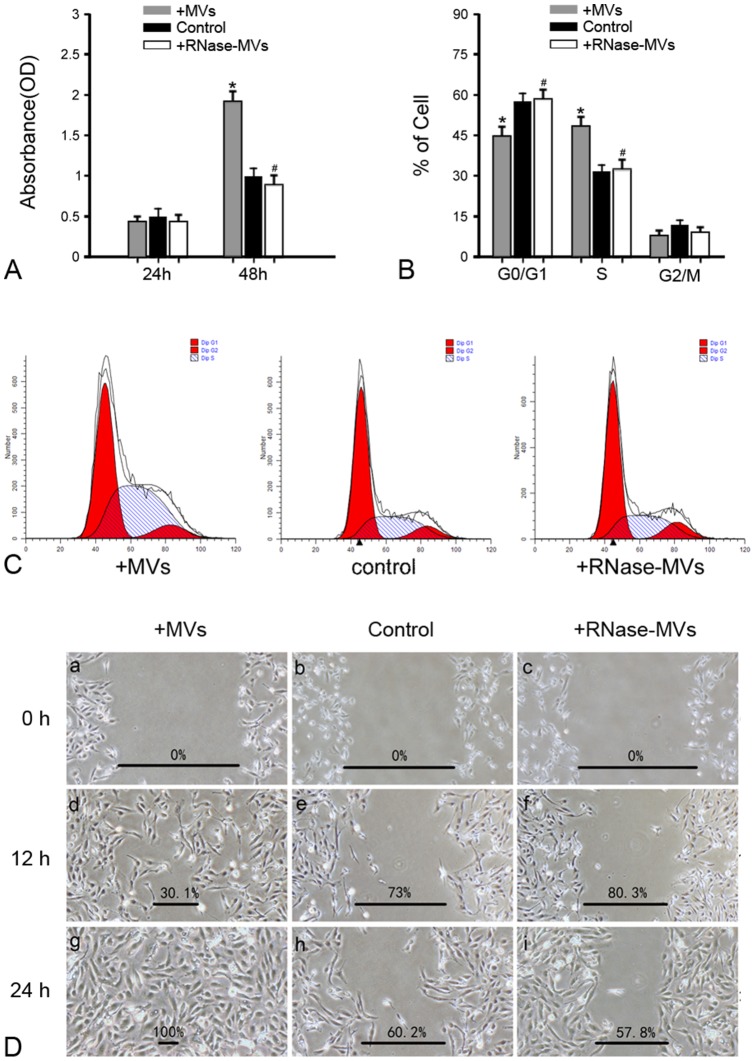
MVs promote the growth and migration of 786-0 cells in vitro.
(A) CCK-8 Assay. After 48-0 cells, MVs greatly promoted cell growth whereas pretreatment with RNase abrogated this effect. The cells incubated with M199 were regarded as control. *P<0.01, MVs vs. control; #
P<0.05, RNase-MVs vs. MVs; (B) (C) Cell cycle analysis. 786-0 cells treated with MVs primarily accumulated in S phase as compared to G0/G1 phase in RNase-MVs or control group. *P<0.05, MVs vs. control; #
P<0.05, RNase-MVs vs. MVs; (D)
Wound Healing Assay
. The migration ability of 786-0 cells was significantly amplified by MVs.